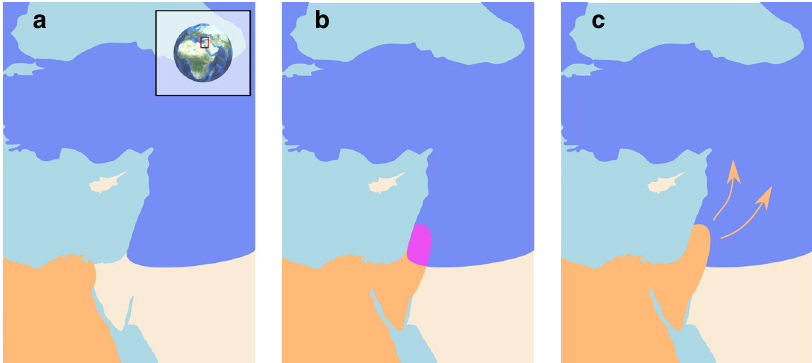
Fig. 1 Schematic representation of interaction between modern humans and Neanderthals. The geographic range of modern humans appears in orange, that of Neanderthals is in blue, and the contact zone in the Levant is in purple. a Neanderthals and Moderns were separated for several hundred thousand years, with Moderns co-evolving with tropical pathogens in Africa and Neanderthals co-evolving with temperate pathogens in Eurasia. b As early as 180 – 120 kya, Moderns began migrating out of Africa into the Levant 4 – 6 . Their range remained restricted to this region for tens of thousands of years, during which they interacted intermittently with Neanderthals 4,7 – 9 . We propose that during this period, each species was exposed to novel pathogen packages carried by the other species and experienced disease burden. Note that the contact zone depicted here may have been larger, possibly including regions in the Arabian Peninsula 36 . c Around 45 – 50 kya, the inter-species dynamics destabilized and Moderns began expanding further into Eurasia. Within several thousand years, Moderns replaced Neanderthals throughout Eurasia